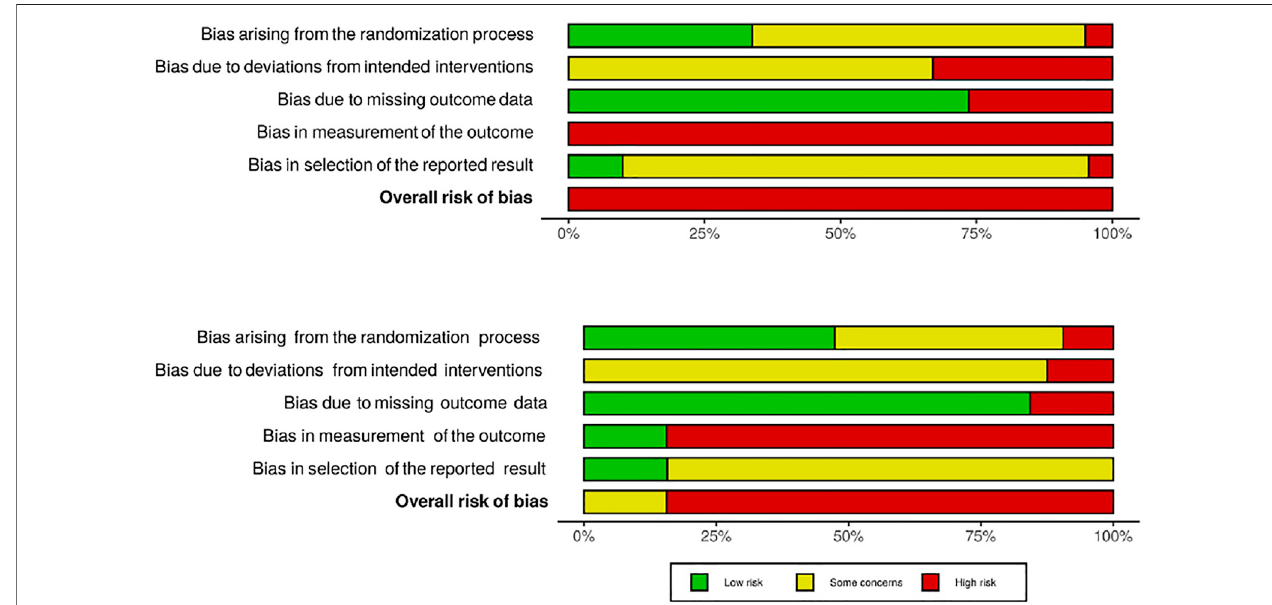
FIGURE 2 | Combined risk of bias judgements of randomized studies reporting pain (A) and anxiety (B) outcomes.